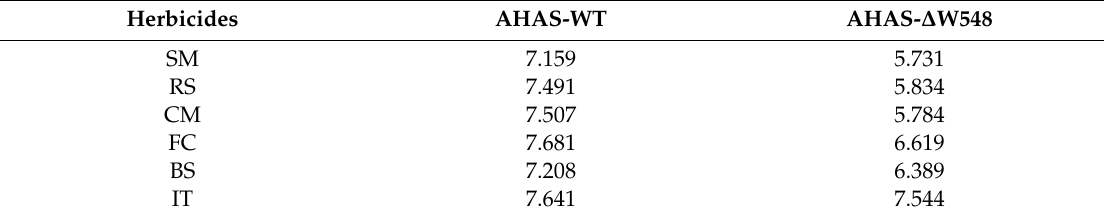
Figure 1. Herbicides bind and block the channel leading to the active site. The molecular surfaces of the monomers were depicted as pink and cyan, respectively. The residues were labeled on the surfaces. ’ indicated residues from different monomers. W548 was shown as a red stick-ball model with the red surface. The herbicides were shown as color stick-ball models with white carbon atoms, blue nitrogen, red oxygen, cyan fluorine, yellow sulfur, and green chloride. Table 1. Molecular docking scores for herbicides in different AHAS.